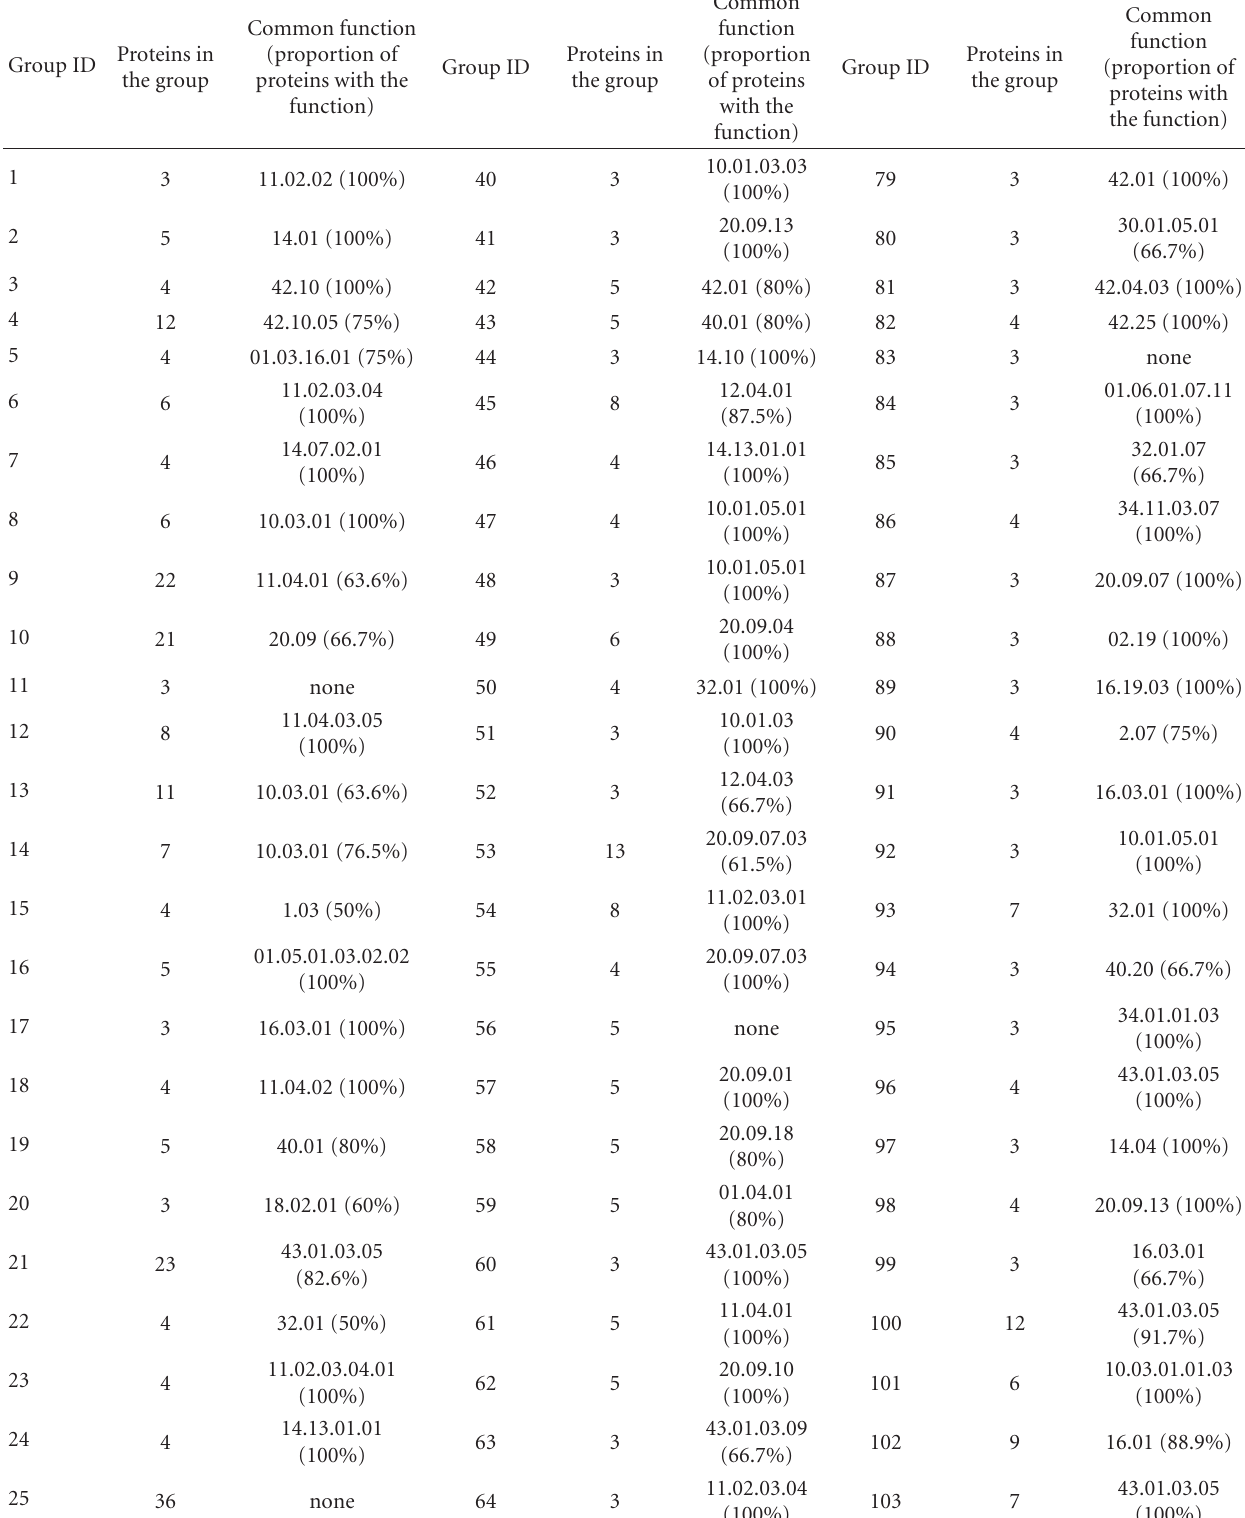
Table 1: Functional groups identified from the yeast protein interaction data. 68 modules have at least one function shared by all the proteins in the groups (100% sharing), and 39 groups have a function shared by more than 50% of the proteins in the groups. Only 9 groups have no function shared by > 50% of the proteins in the group. This table shows only one function with the highest functional coherence in each group. All the functions shared by more than 50% of the proteins in each group are available at